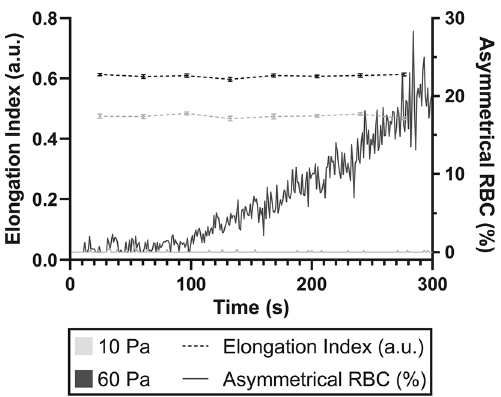
Figure 5. Elongation index and frequency of asymmetrical RBC in 10 and 60 Pa shear conditions. While the ensemble average elongation index remains unchanged for both conditions, the fraction of asymmetrical RBC in the 60 Pa increases beyond ~ 100 s of cumulative exposure, while the 10 Pa condition remains unchanged. Asymmetrical RBC are presented as a percentage of total cell counts per